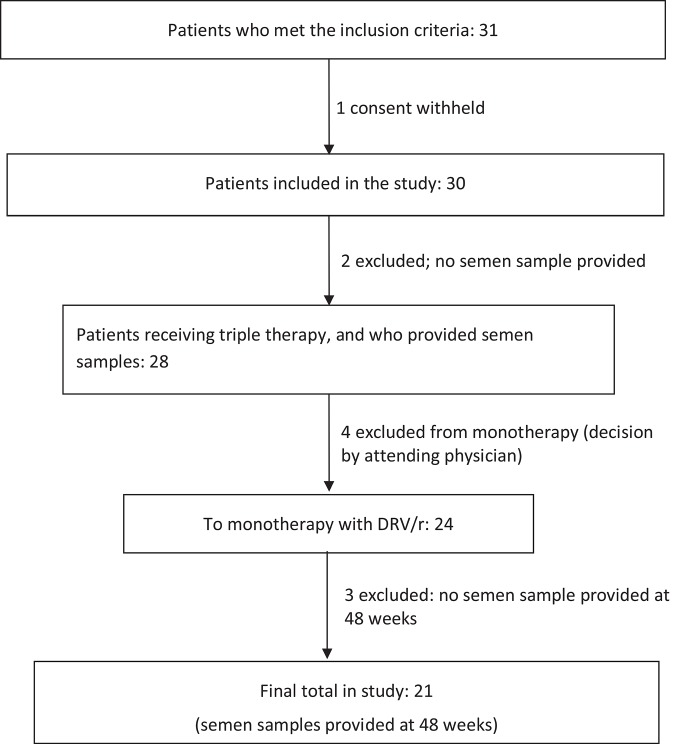
Flow of patients through the study.